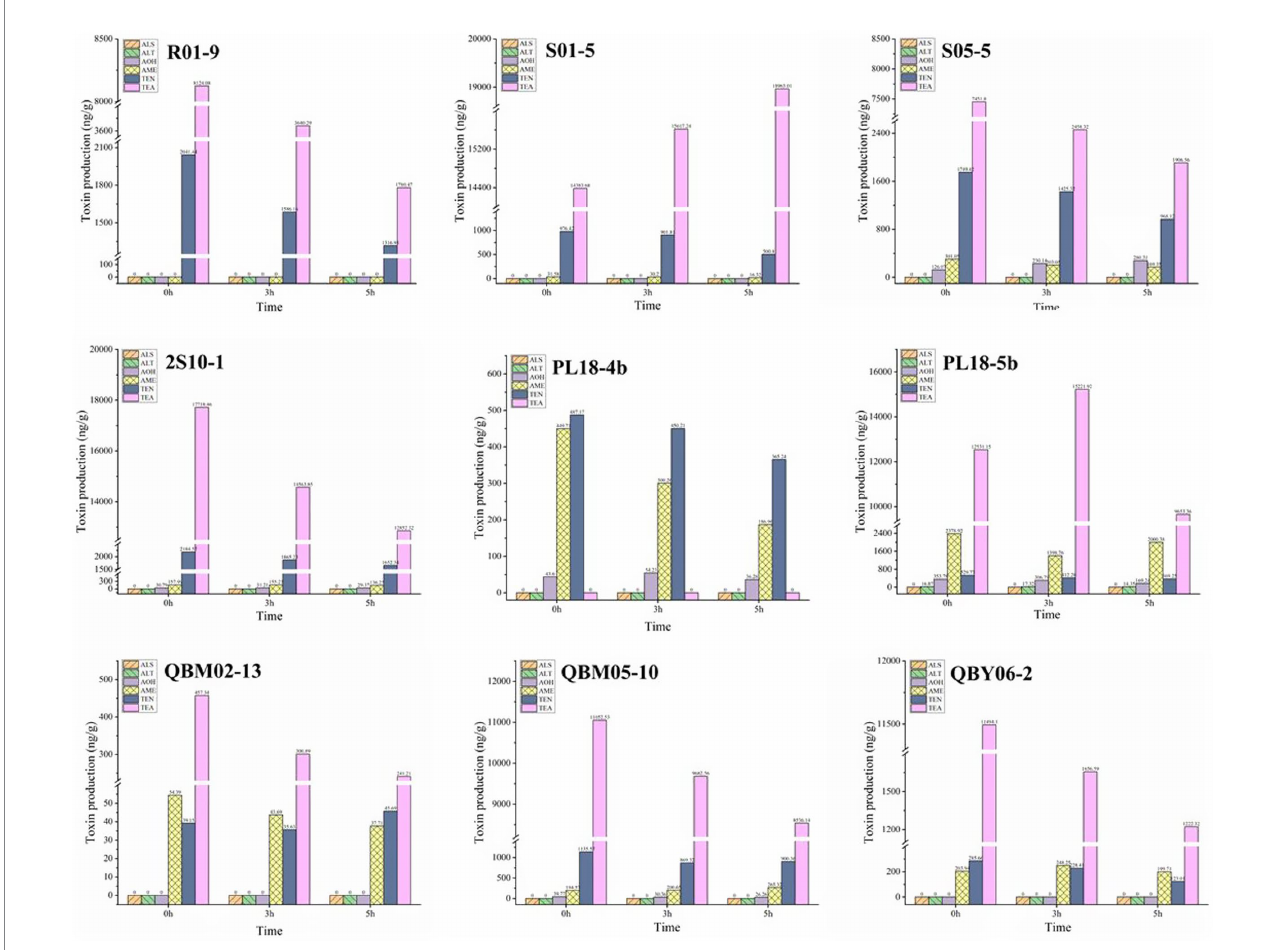
FIGURE 5 The effect of UV irradiation on the toxigenic capacity of nine Alternaria